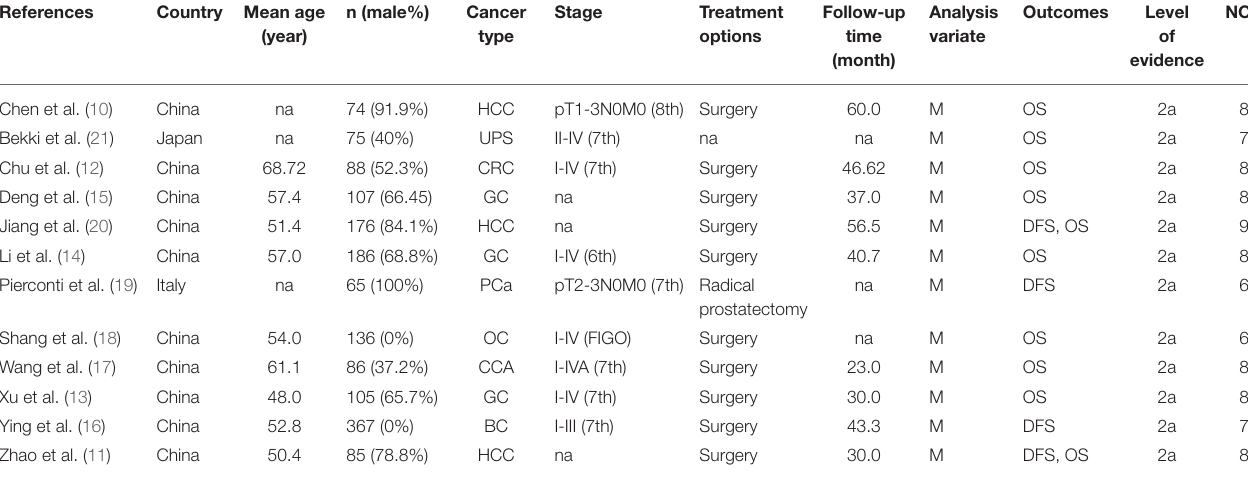
TABLE 1 | Characteristics of included